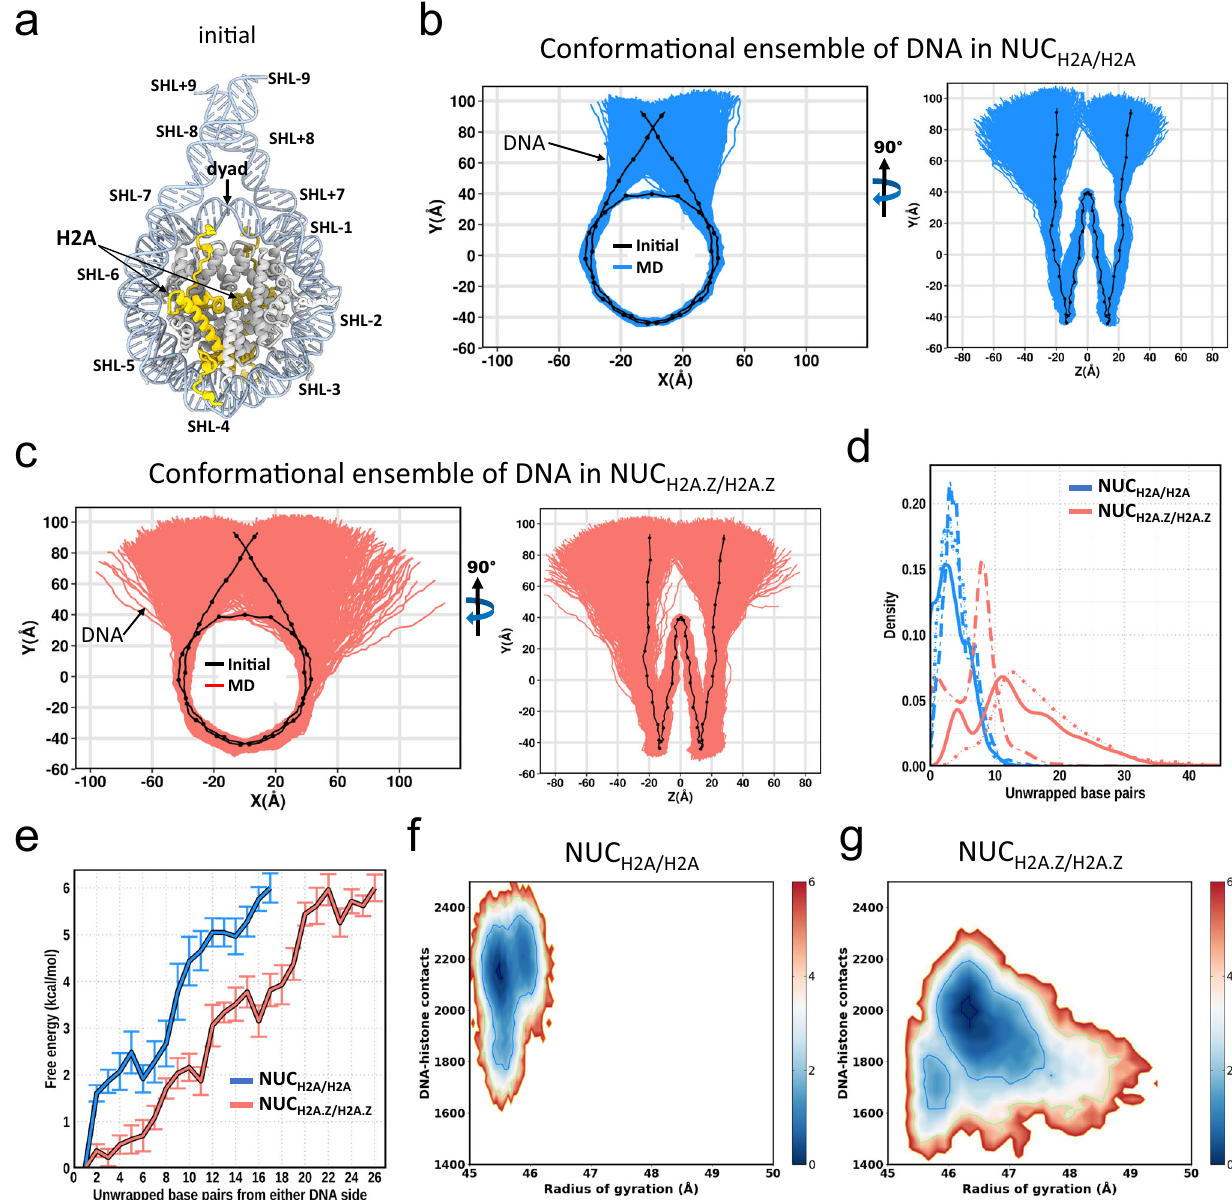
Fig. 1 | H2A.Z facilitates nucleosomal DNA unwrapping. a Cartoon representa- tion of the initial nucleosome structure, histone tails of H3, H4, and H2B are not shown.Superhelicallocations(SHLs)wheremajorgroovesfacethehistonesurface are labeled. Histone H2A is shown in yellow and other histones are shown in gray. b 2D projection of DNA conformations for NUC H2A/H2A (blue) from the combined ensemble of three independent simulation runs, 7 µ s each (see Supplementary Fig. 3 for results for each simulation run). The black dotted line representes the initial conformaion. c Same as b but for NUC H2A.Z/H2A.Z (red). d Distributions of a total number of unwrapped base pairs of NUC H2A/H2A (blue) and NUC H2A.Z/H2A.Z (red) nucleosomes for three independent simulation runs (solid, dotted and dashedlines).Thetotalnumberofunwrappedbasepairsisasumofthenumberof